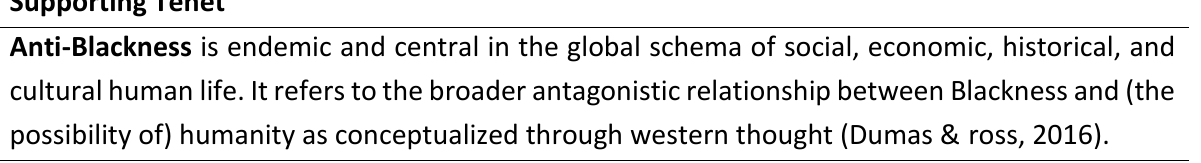
Table 2. Black Critical Race Theory (alexander, 2022) Supporting